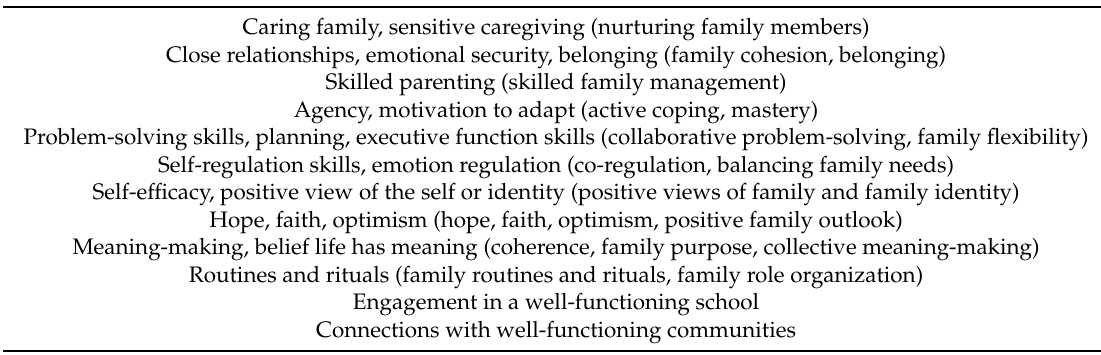
Table 2. Shortlist of common resilience factors for child development. Caring family, sensitive caregiving (nurturing family members) Close relationships, emotional security, belonging (family cohesion, belonging) Skilled parenting (skilled family management) Agency, motivation to adapt (active coping, mastery) Problem-solving skills, planning, executive function skills (collaborative problem-solving, family flexibility) Self-regulation skills, emotion regulation (co-regulation, balancing family needs) Self-efficacy, positive view of the self or identity (positive views of family and family identity) Hope, faith, optimism (hope, faith, optimism, positive family outlook) Meaning-making, belief life has meaning (coherence, family purpose, collective meaning-making) Routines and rituals (family routines and rituals, family role organization) Engagement in a well-functioning school Connections with well-functioning